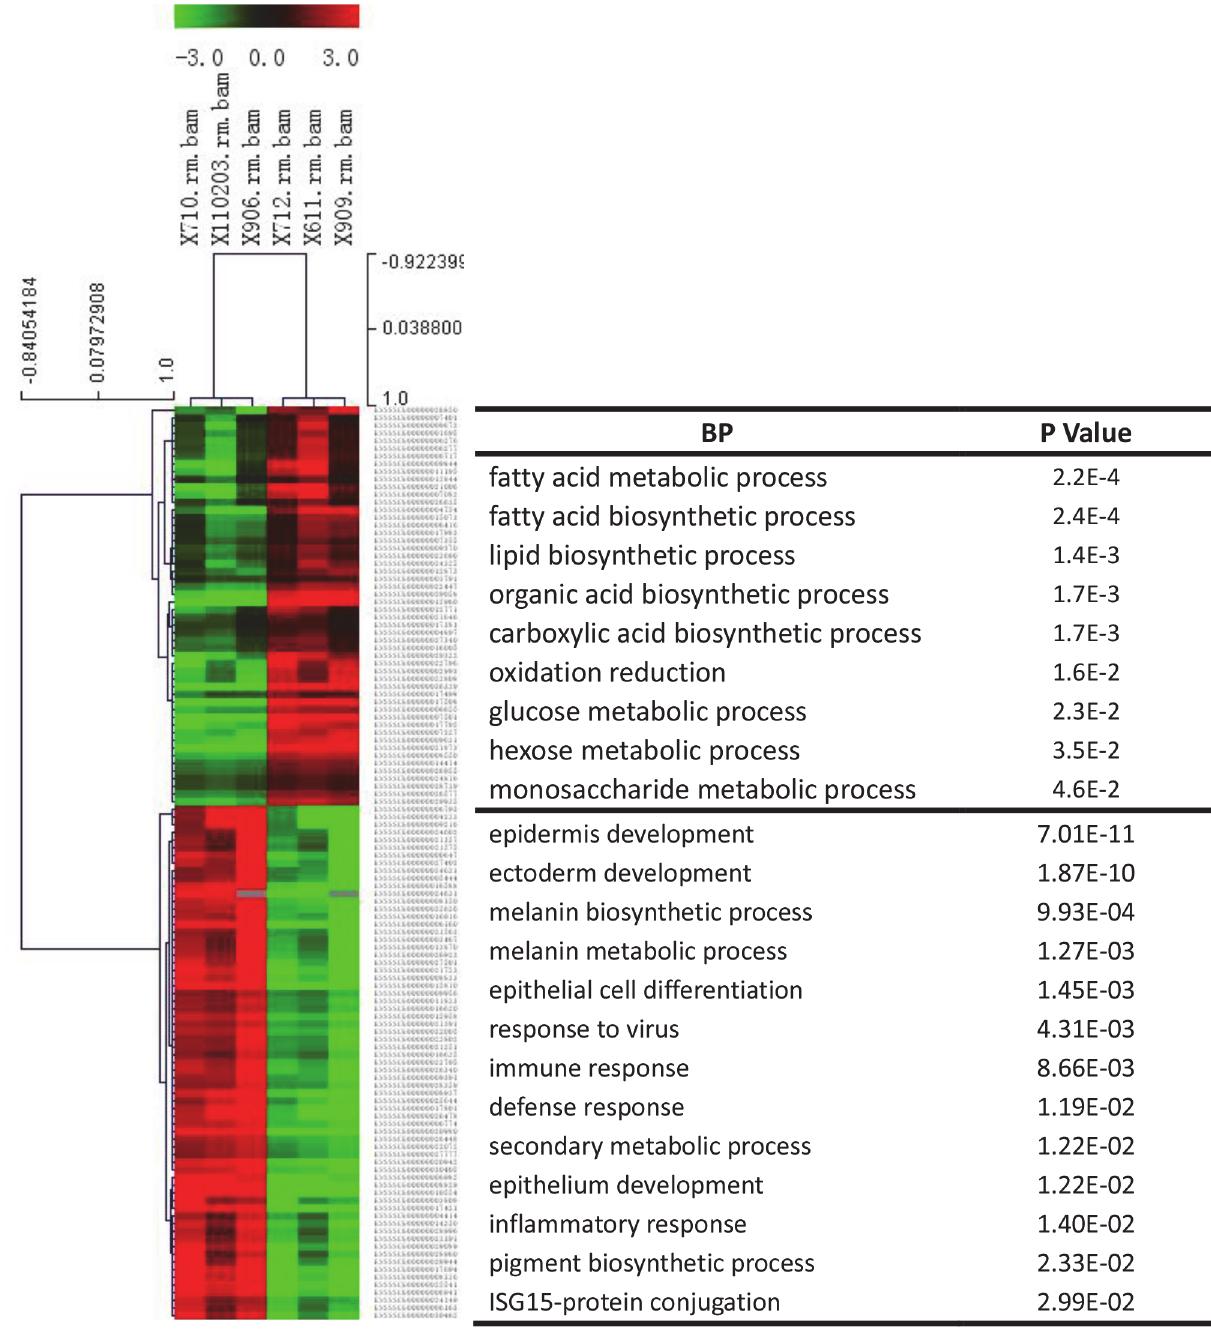
Fig 5. Heatmap of differentially expressed genes (DEGs) in adipose tissue and GO analysis. The heatmap was generated by hierarchical cluster analysis of DEGs. The processes listed opposite the upper half of the heatmap are gene ontology annotation processes of the up-regulated genes [biological process (BP)]. The lower processes are those (BP) of the down-regulated